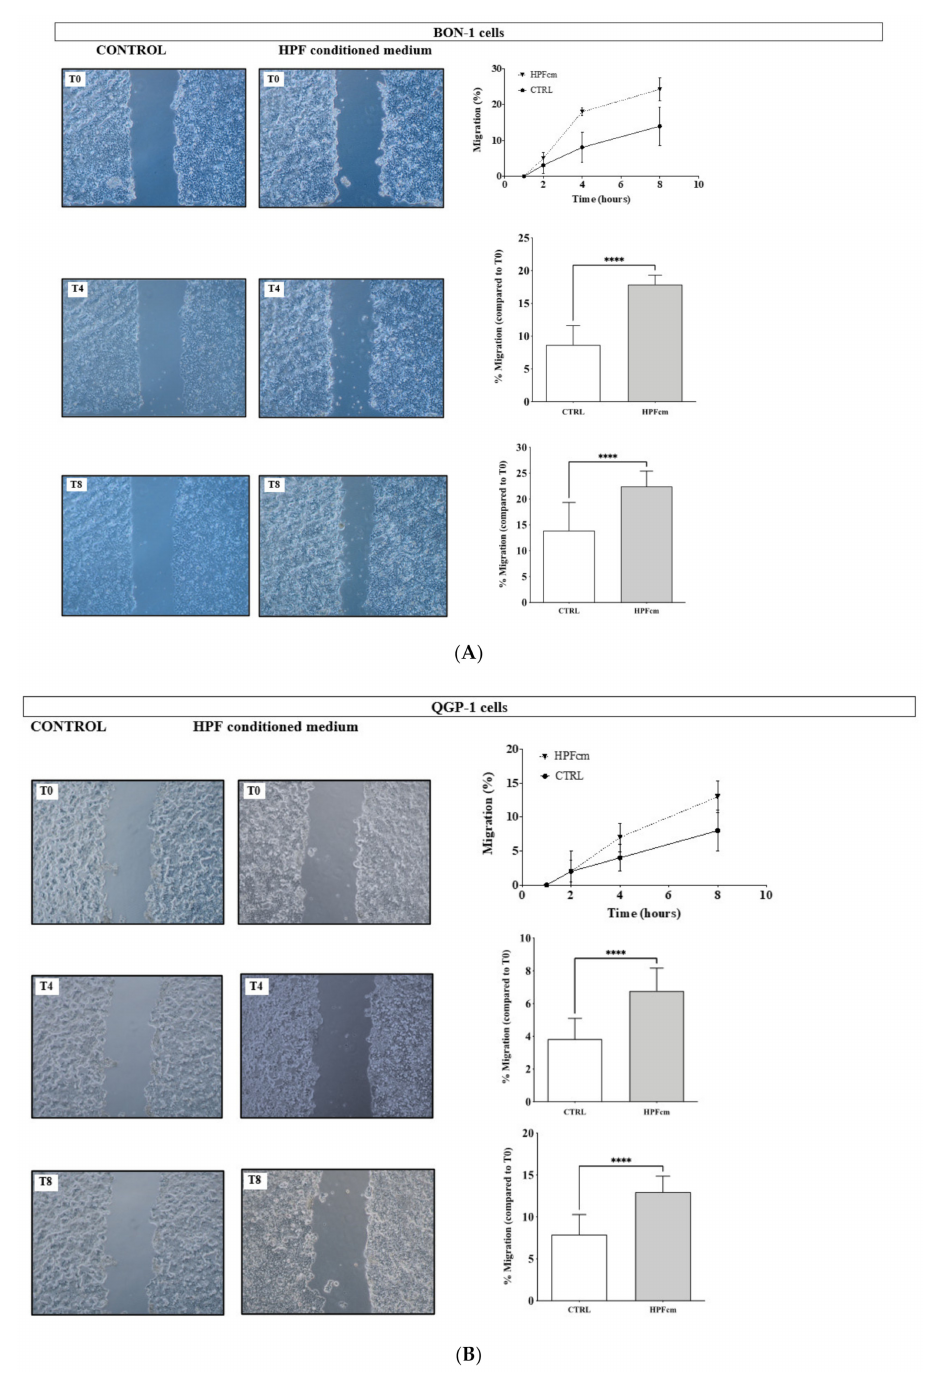
Figure 10. Impact of HPF-conditioned medium on the migration potency of BON-1 ( A ) and QGP-1 cells ( B ). ( A ) Pictures taken at T0, T4 and T8 for BON-1 during the migration assay showing the scratch made by the pipet point. Cells were incubated either with DMEM/F12 + 0.2% BSA (control) or with DMEM/F12 + 0.2% BSA + HPFcm in a 1:1 ratio (HPFcm). Note the migrating cells between the two banks. The migration assay during the time of the experiment (upper right panel) and migration assay at T4 (middle panel) and T8 (lower panel), respectively, compared to T0 in control and HPFcm conditions. ( B ) Pictures taken at T0, T4 and T8 for QGP-1 following the same protocol. Migration assay of QGP-1 during the time of the experiment (upper right panel) and migration assay at T4 (middle panel) and T8 (lower panel), respectively, compared to T0 in control and HPFcm conditions. **** p <